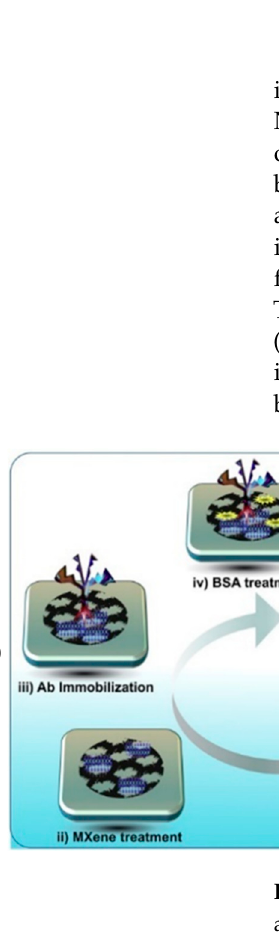
Table 8. MXene − based other biosensors identify units, target, and analytical parameters.